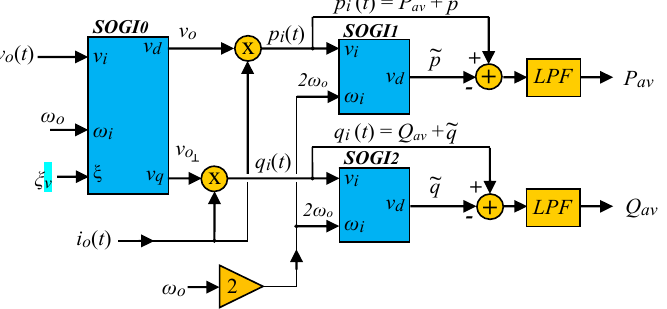
Figure 9. Addition to Figure 8 of a new SOGI for archiving the quadrature component of the output voltage v o ⊥ ( t ).